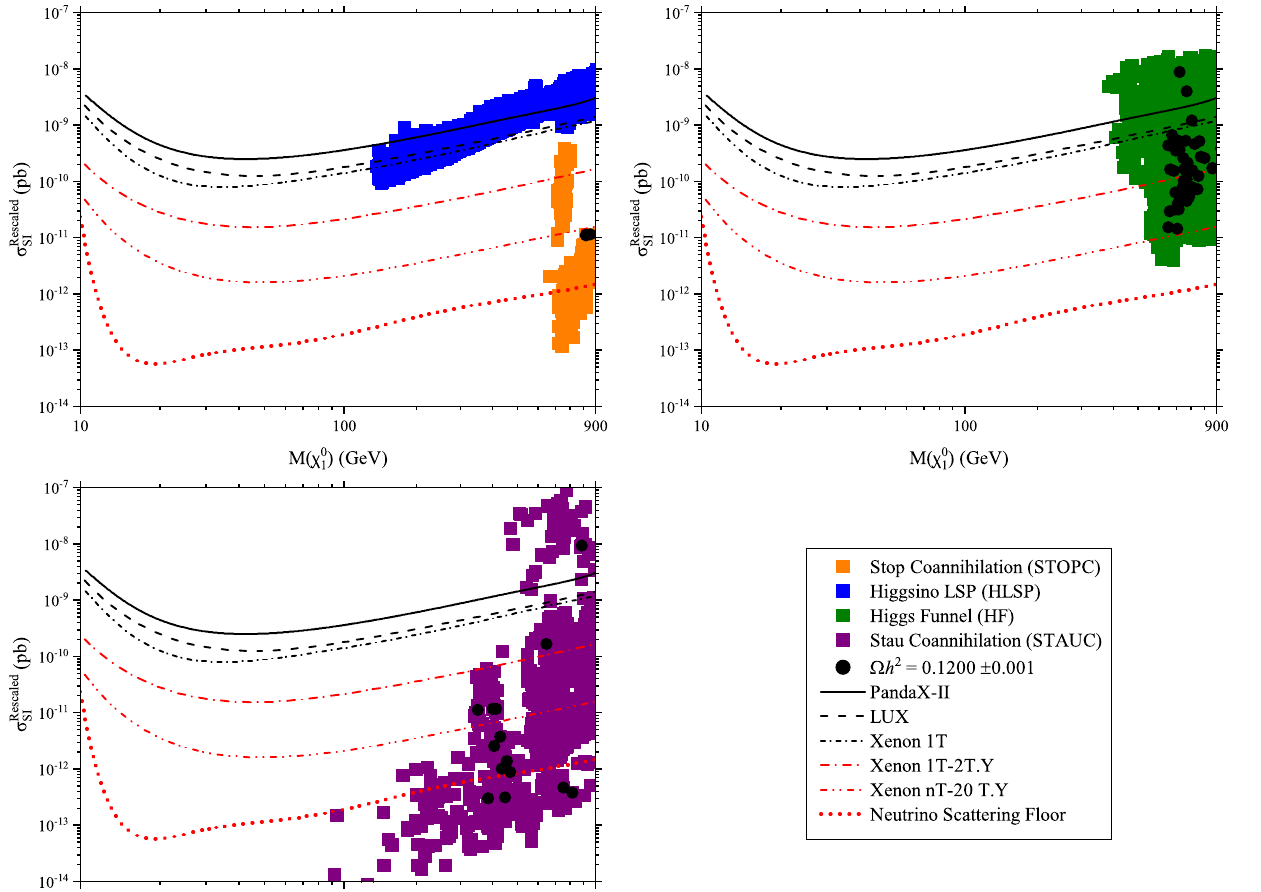
in addition to rare decay and current LHC SUSY search constraints. The round black dots represent those points that can also satisfy the recent 2018 Planck Collaboration satellite relic density measurements of (cid:9) h 2 = 0 . 120 ± 0 .